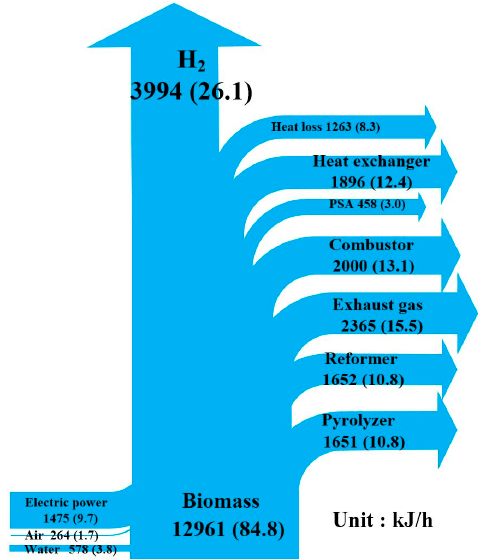
Figure 7. Hydrogen production system exergy diagram (percentage of total exergy, %).